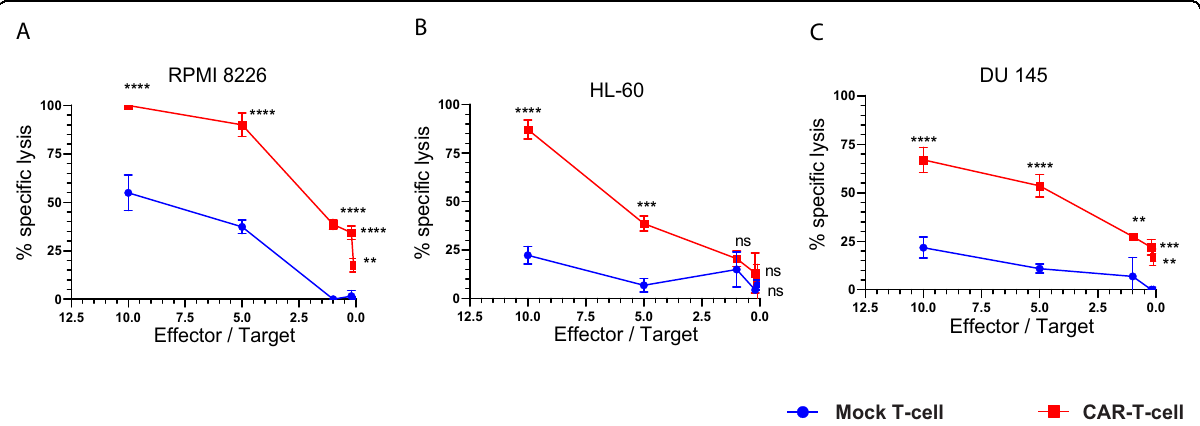
Fig. 3 CD126-targeted CAR-T cells demonstrated potent in vitro activity against multiple tumor cell lines. Bioluminescence cell killing was performed in ultrachilli-luciferase-expressing cancer cell lines, a RPMI, b HL-60, and c DU145 when co-cultured with either CAR-T or mock T cell at effector-to-target ratios of 10, 5, 1, 0.2, and 0.1 ( n = 12). Percent speci fi c lysis was quanti fi ed after 16 hours of incubation. Two-way ANOVA and multiple comparison test. n.s. Not signi fi cant. ** P < 0.01, *** P < 0.001, and **** P <